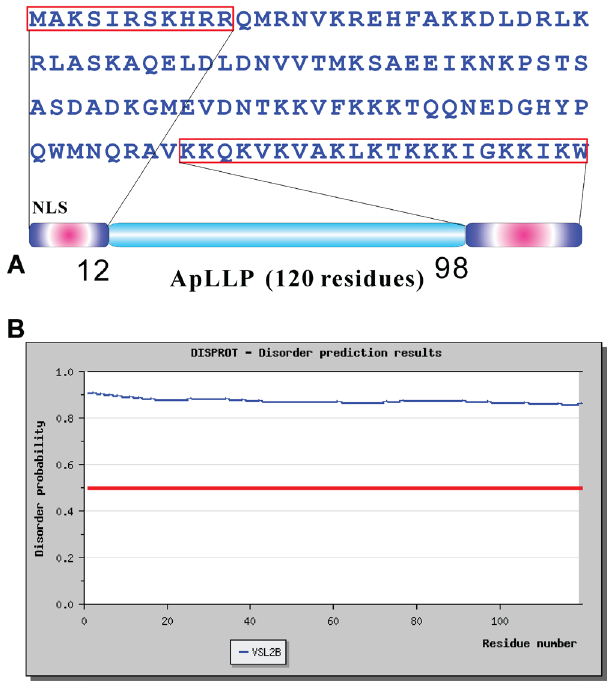
Figure 1. Sequence properties of ApLLP, a 120-residue Aplysia transcriptional activator. ( A ) The sequence of ApLLP, with two Nuclear Localization Signals (NLS) boxed. ( B ) Analysis results of the globularity and disordered regions of ApLLP by